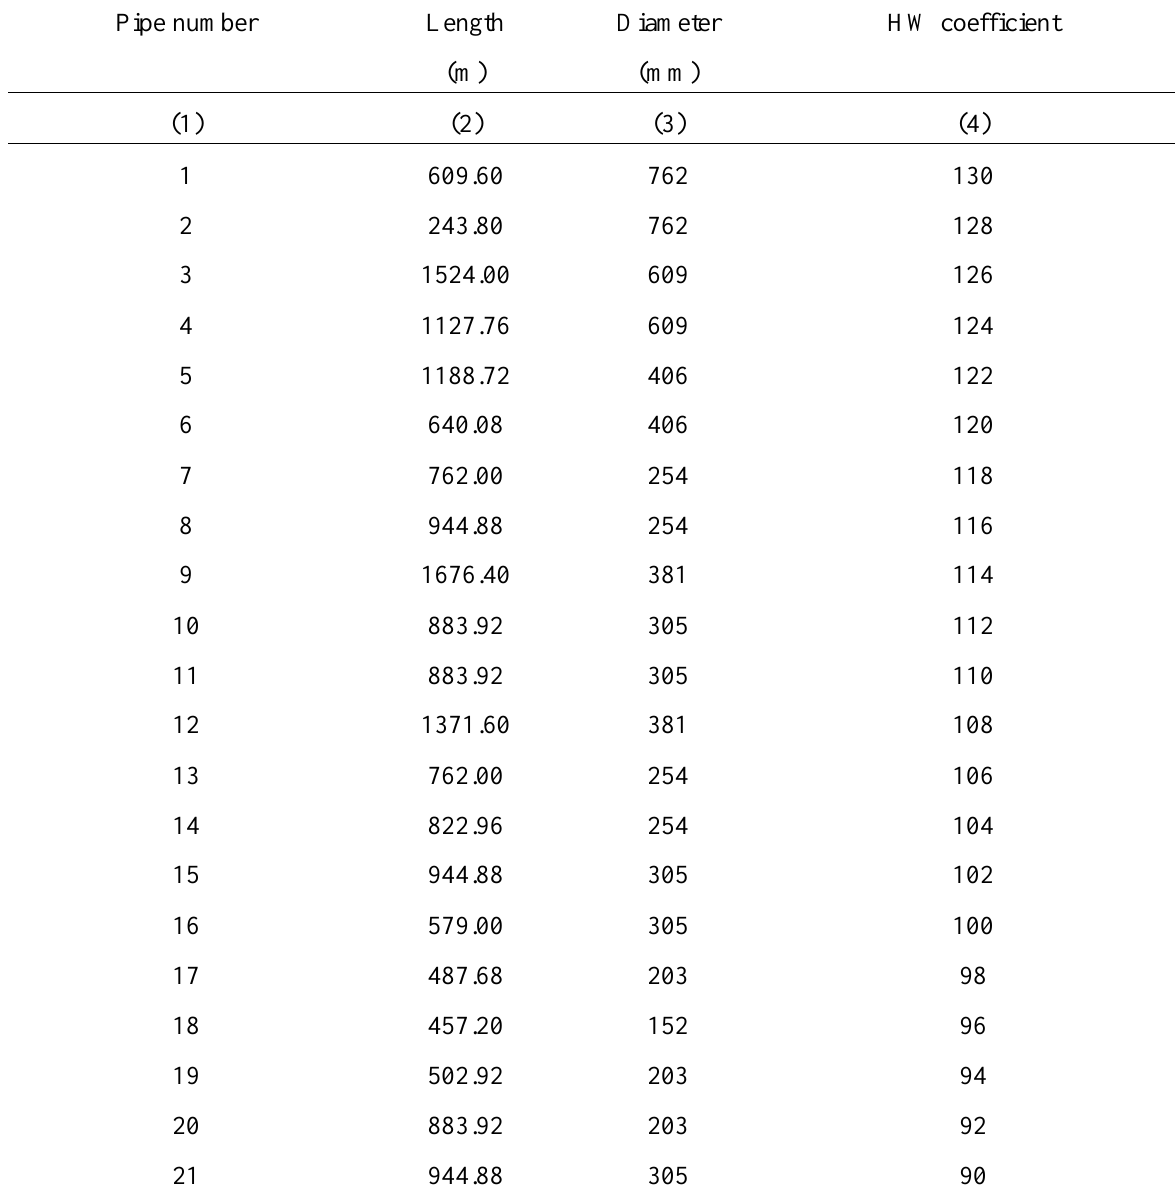
Table 3. Pipe data for illustrative example